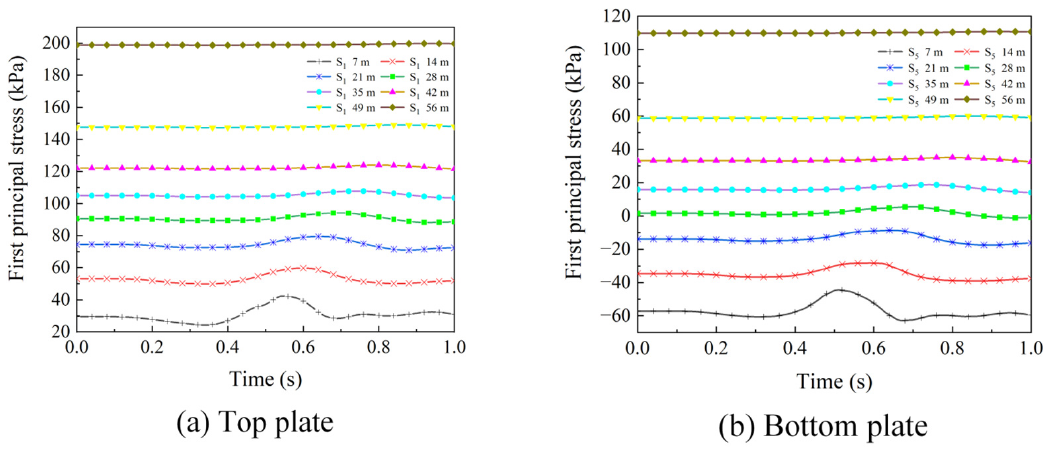
Figure 14. A first principal stress–time curve of the monitoring points.